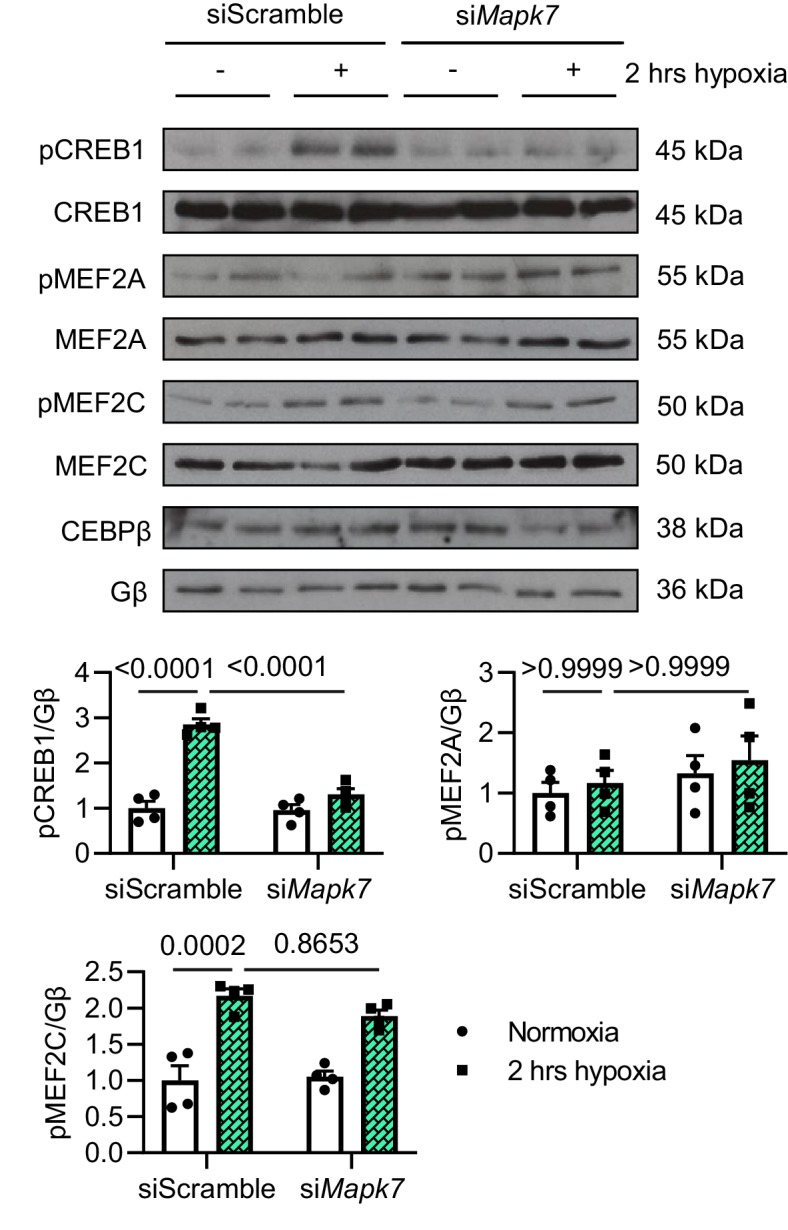
Analysis of MAPK7 downstream effectors after hypoxia.Potential MAPK7 downstream effectors were analysed in ARCMs by immunoblots and quantification. CREB1 phosphorylation under short-term hypoxia was blocked by Erk5 deficiency (N = 4 experiments). Data presented as mean ± SEM. Two-way ANOVA followed by Bonferroni post hoc tests was employed to compare groups.Figure 3—figure supplement 6—source data 1.Analysis of MAPK7 downstream effectors after hypoxia.